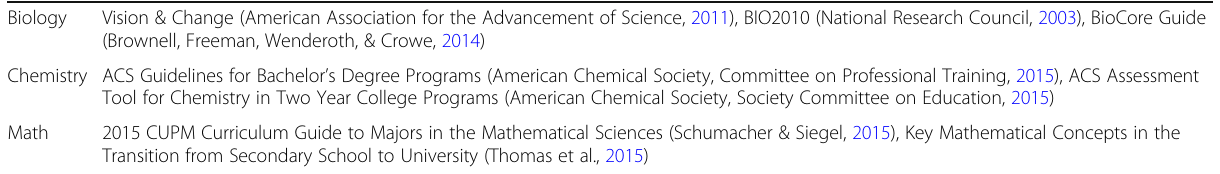
Table 1 Examples of guiding disciplinary documents in biology, chemistry, and math Biology Vision & Change (American Association for the Advancement of Science, 2011), BIO2010 (National Research Council, 2003), BioCore Guide (Brownell, Freeman, Wenderoth, & Crowe, 2014) Chemistry ACS Guidelines for Bachelor ’ s Degree Programs (American Chemical Society, Committee on Professional Training, 2015), ACS Assessment Tool for Chemistry in Two Year College Programs (American Chemical Society, Society Committee on Education, 2015) Math